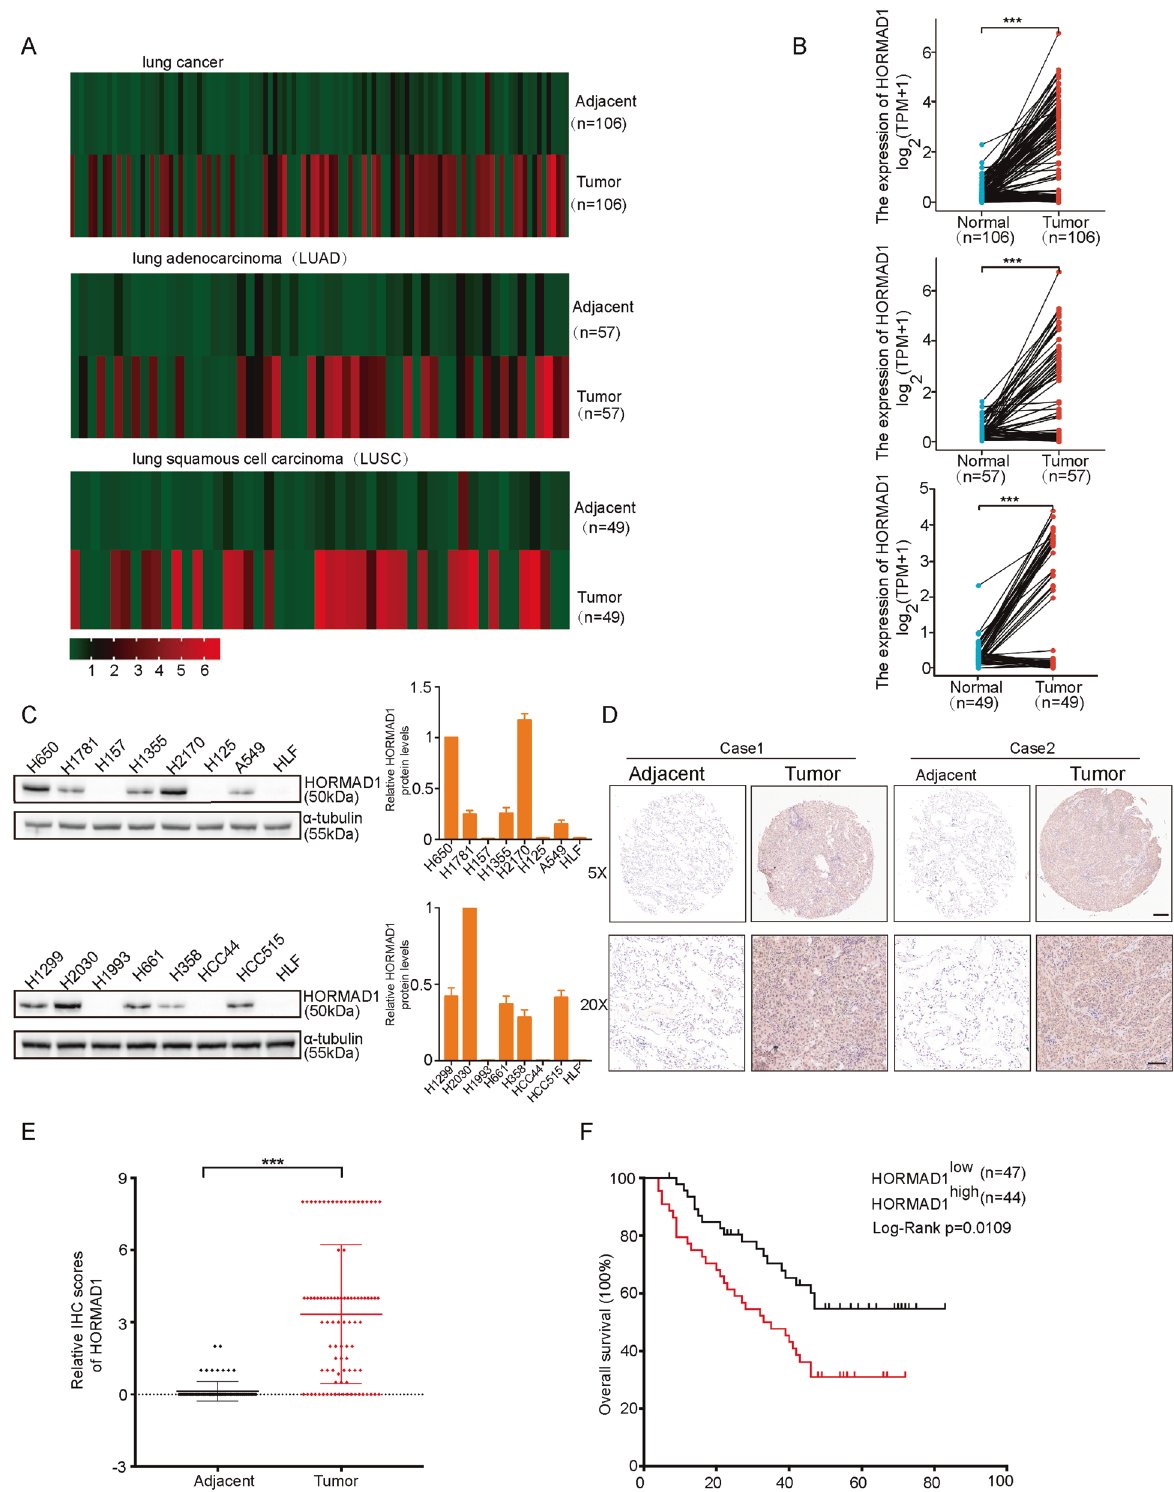
of cancer remain largely unknown. HORMAD1 is aberrantly expressed in multiple cancers, such as ovarian cancer, breast cancer, and lung cancer. Aberrant HORMAD1 expression in cancer cells has been shown to be associated with genomic instability and DNA damage repair pathway regulation [19 – 21].